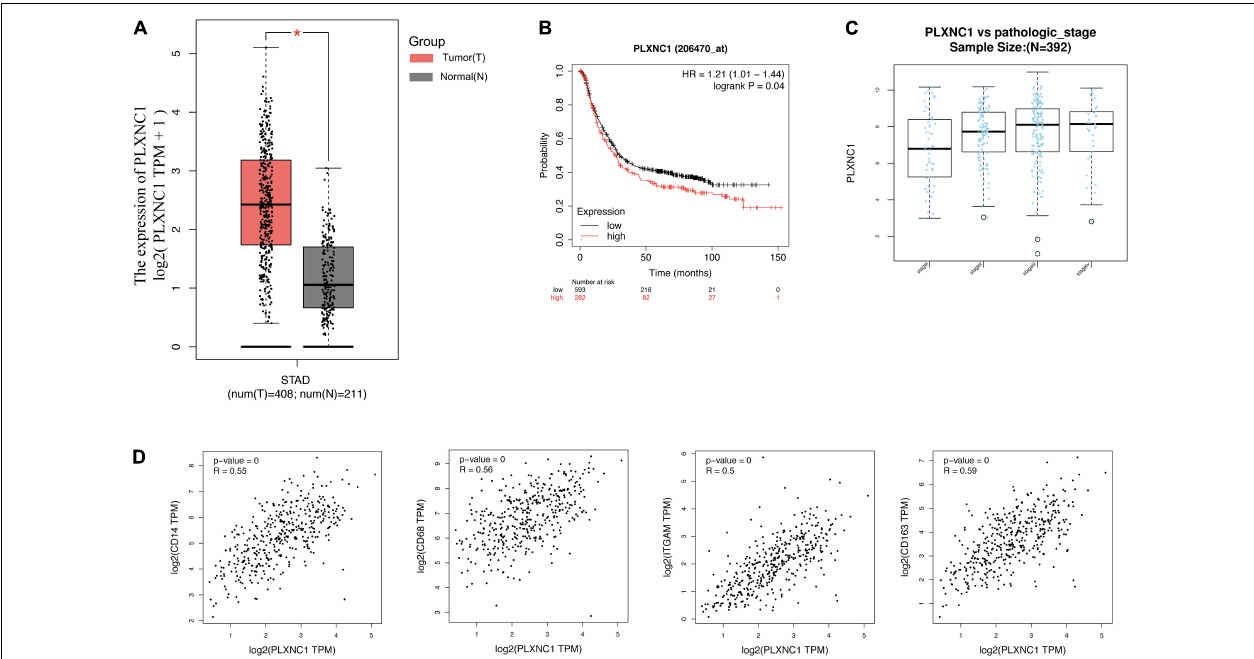
FIGURE 5 | (A) PLXNC1 was significantly upregulated in STAD samples, verified in the GEPIA database with STAD (red) and normal (gray) samples ( p < 0.05). (B) PLXNC1 was a prognostic risk factor in patients with STAD (log-rank p = 0.04) in the Kaplan-Meier Plotter online database. (C) PLXNC1 expression in STAD patients according to pathologic stage in the LinkedOmics database. PLXNC1 expression increased significantly as pathologic stage progressed ( p < 0.001). (D) Correlation between PLXNC1 and macrophage surface antigens CD14 [ r = 0.56 (Pearson), p < 0.0001], CD68 [ r = 0.56 (Pearson), p < 0.0001], CD11b [ r = 0.5 (Pearson), p < 0.0001], and CD163 [ r = 0.59 (Pearson), p < 0.0001] in the GEPIA database.